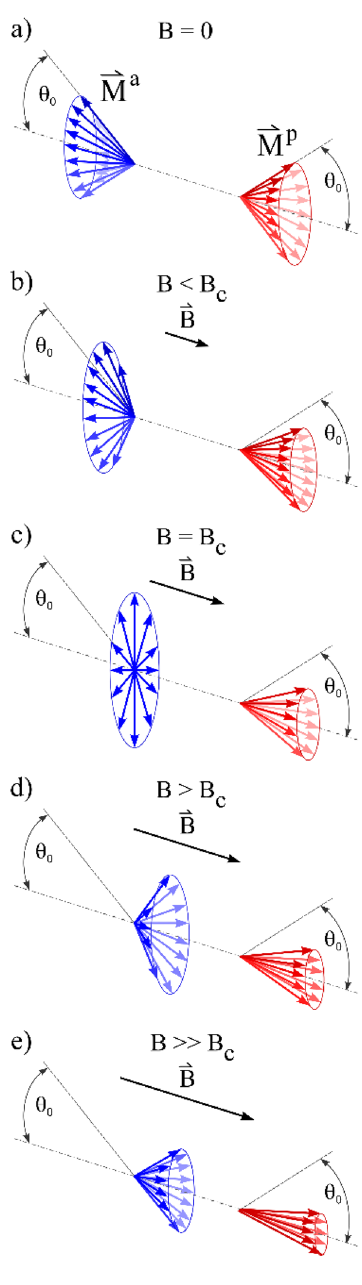
Figure 5. Schematic presentation of the dynamics of magnetic-field-driven AFM-to-paramagnetic quantum phase transition in Ce 3 Al for the field applied along the AFM axis. ⇀ M oriented parallel and antiparallel relative to the AFM